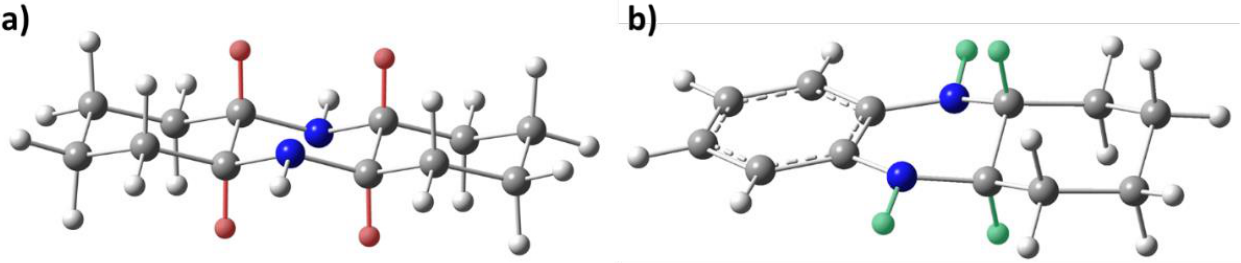
Figure 6. Molecular structure of ( a ) tetradecahydrophenazine and its dehydrogenated intermediate ( b ) 8HP-c according to DFT calculations (B3LYP[GD3BJ]/6-31+G*). Red lines and circles denote hydrogen atoms facing the opposite sides of the molecular plane and thus creating a steric hindrance for dehydrogenation reaction. Green lines and circles denote hydrogen atoms facing similar sides of the molecular plane and thus being sterically accessible to dehydrogenation.